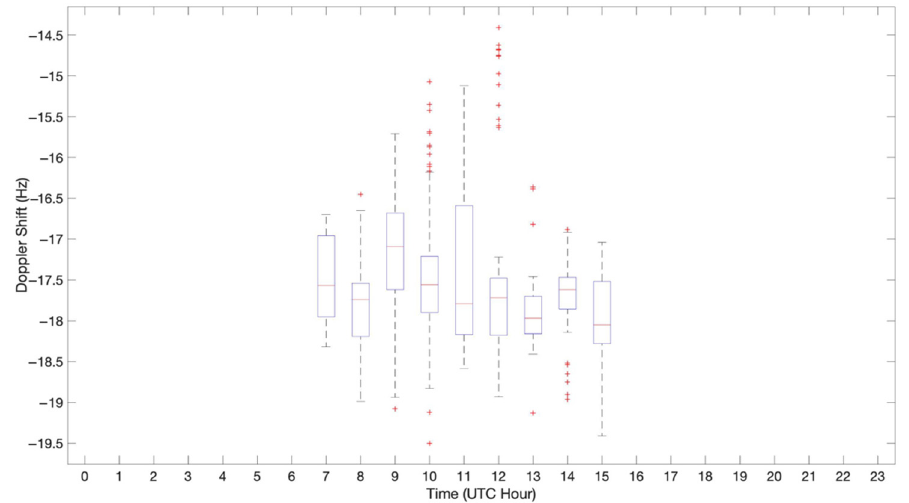
Figure 13. Frequency offset received vs. time.